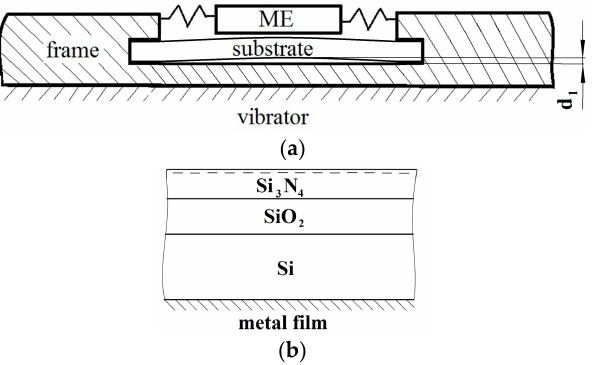
Figure 8. Impact microgenerator: ( a ) chematic picture; and ( b ) structure of electret film on the substrate.